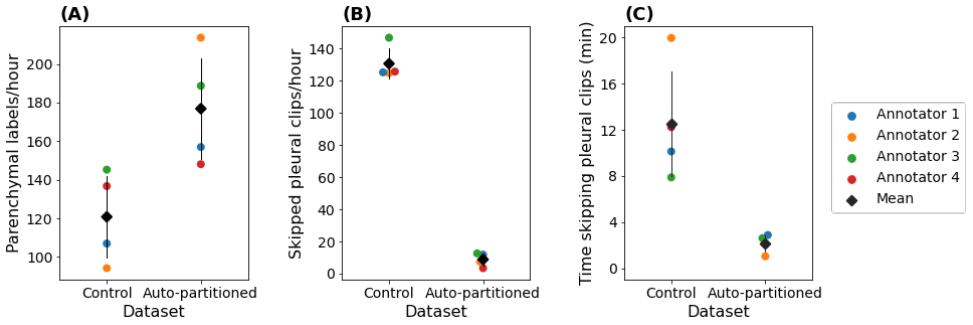
Figure 8. Efficiency analysis of control (non-partitioned) and auto-partitioned (parenchymal- predicted) sprints from the parenchymal-specific labelling task. Time metrics exported from the labelling platform were used to determine the rate of parenchymal labels/hour ( A ), skipped pleural clips/hour ( B ), and the time spent skipping pleural clips ( C ) for each of the four annotators. The diamond represents the mean, and error bars represent standard